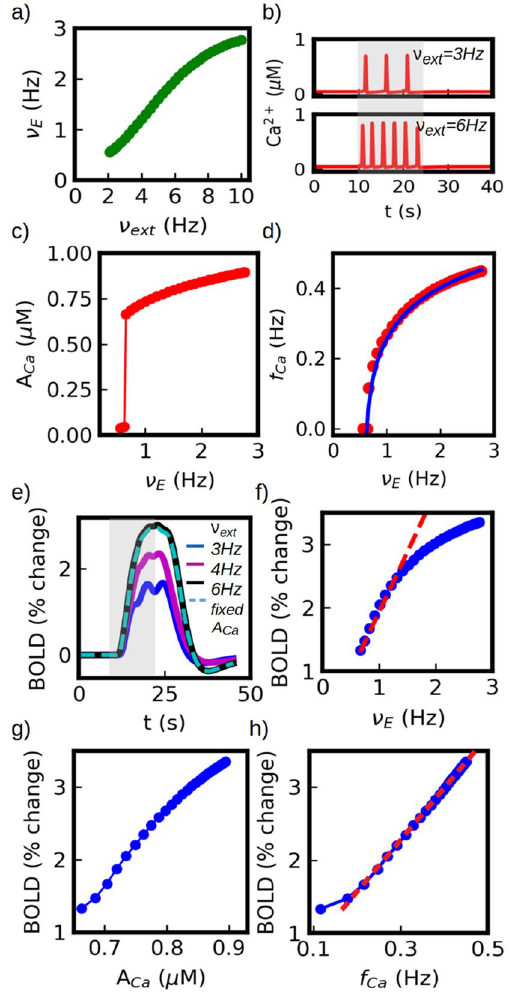
Figure 4. Neuronal and calcium coding of an external stimulus. ( a ) Average firing rate of the excitatory neuronal population as a function of the external stimulus intensity (in terms of the external excitatory rate ν ext ). ( b ) Astrocytic calcium activity for two values of ν ext . ( c , d ) Amplitude and frequency of calcium-spikes as a function of excitatory firing rate. External stimuli are first codified by neuronal activity which modulates the amplitude and frequency of the calcium response. In panel ( d ) we show a fit with a logarithmic function (solid blue line, see main-text). ( e ) BOLD response for different stimulus intensity (for a comparison with experimental results see Fig. 2. ( b ) In dashed line we show the results for ν ext =6 Hz with calcium-spike amplitude limited to A Ca =0.65 µ M for arachidonic acid production, indicating that the main increase in BOLD response is not driven by the spike-amplitude. Frequency-coding accounts for about 95 % of the variation. ( f ) BOLD response as a function of excitatory activity. A linear fit is shown in red dashed line, which describes ∼ 75 % of the total BOLD variation. ( g , h ) BOLD response to stimuli intensity parameterized in terms of calcium- spike amplitude and frequency. A linear fit is provided in panel ( h ) (dashed red line). For a comparison of panel ( g ) with experimental results see Ref. 17